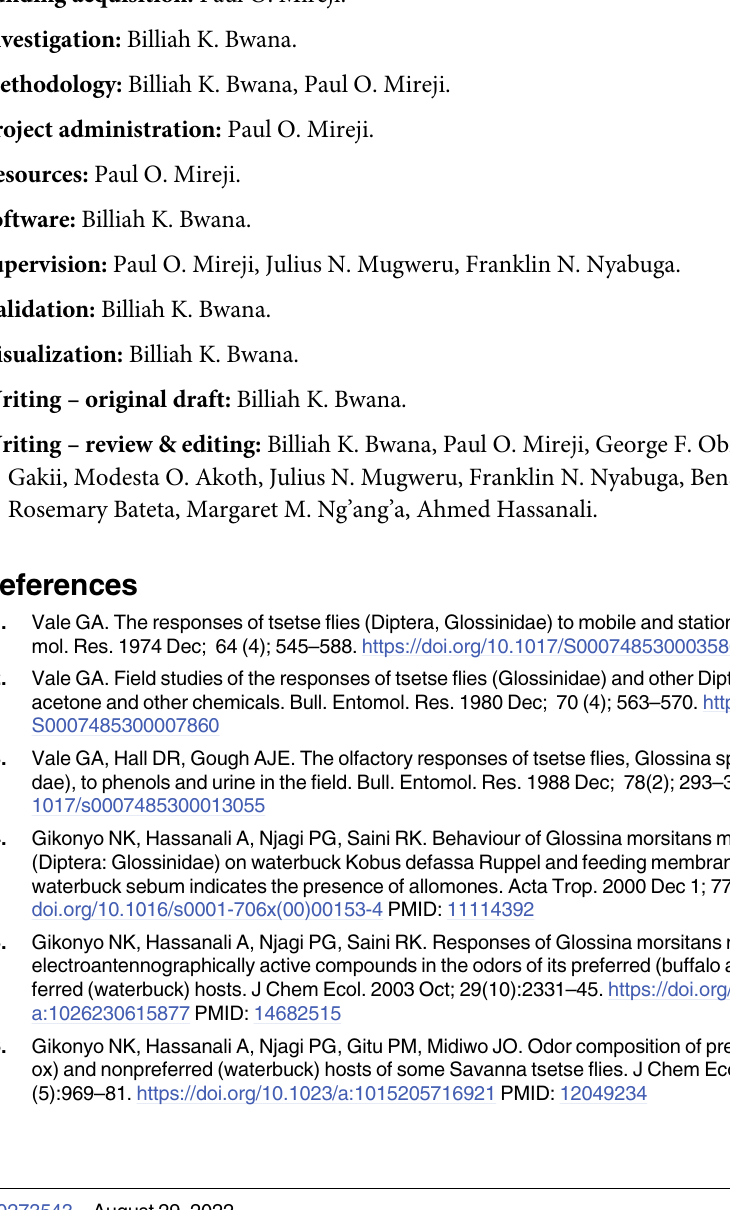
S5 Table. InterProScan classification of protein domains of novel male G . m . morsitans antennae expressed